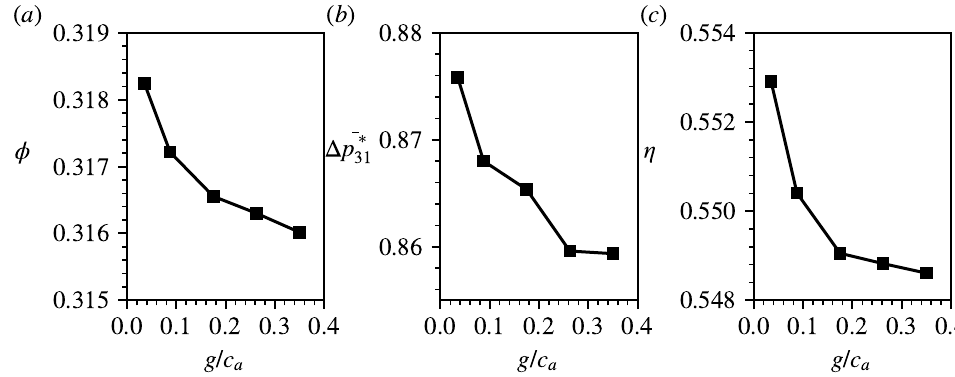
Figure 11. Aerodynamic performance at two row gaps: ( a ) the total-to-total pressure rise coefficient and ( b ) the adiabatic efficiency.